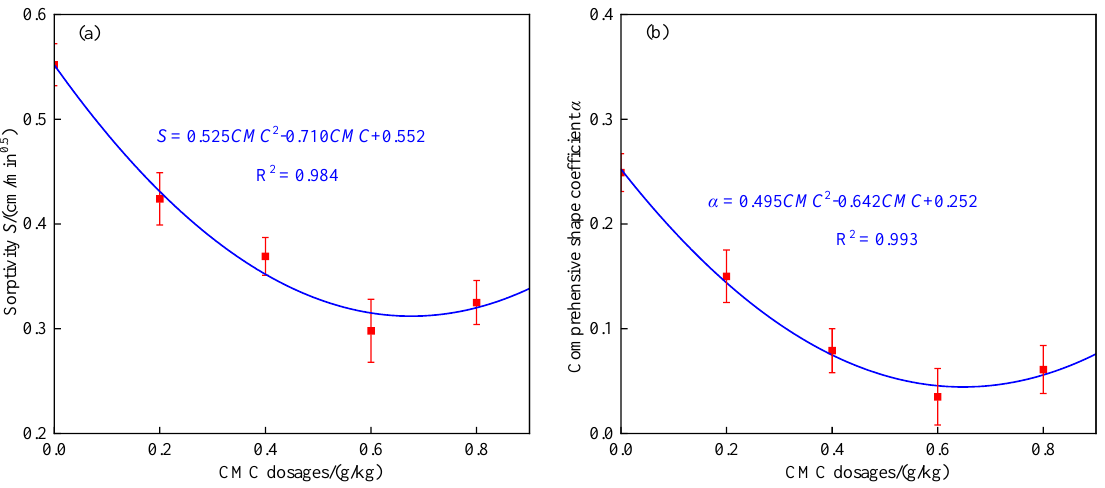
Figure 3. Effect of CMC dosages on infiltration model parameters. ( a ) Sorptivity S ; ( b ) comprehensive shape coefficient ( α ).